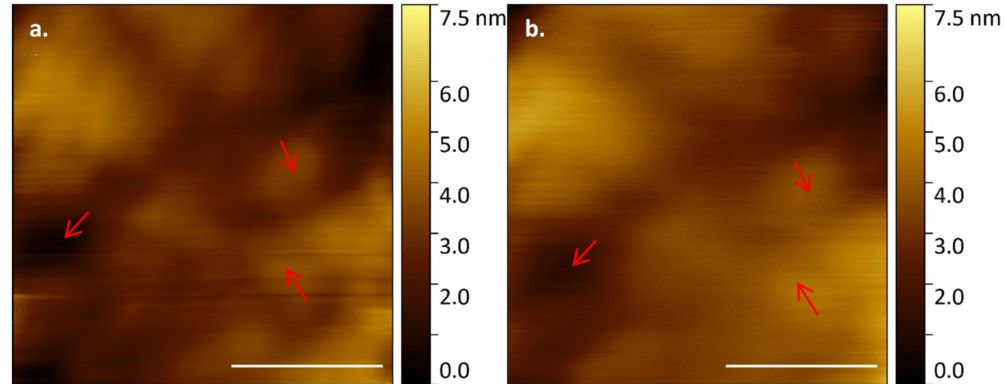
Figure 6. E. huxleyi cell membrane visualised by HS-AFM in liquid (Scale bar 500 nm, Individual frames captured at 2 fps) from near continual data acquisition at ( a ) T = 0 and ( b ) T = 5512 s; arrows mark persistant, recognisable features of the